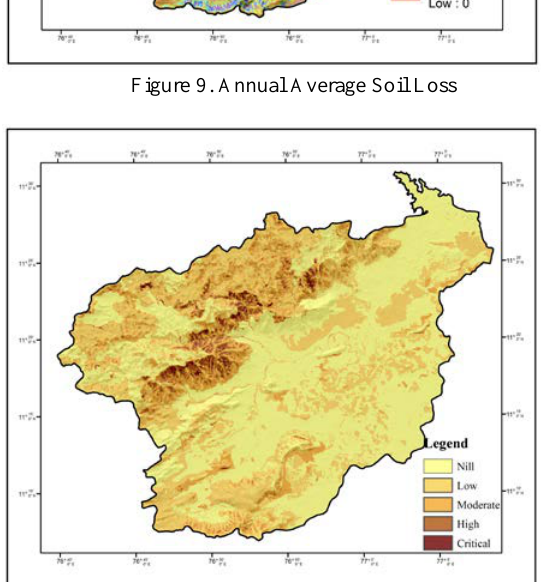
Figure 10. Soil Erosion Severity Classes